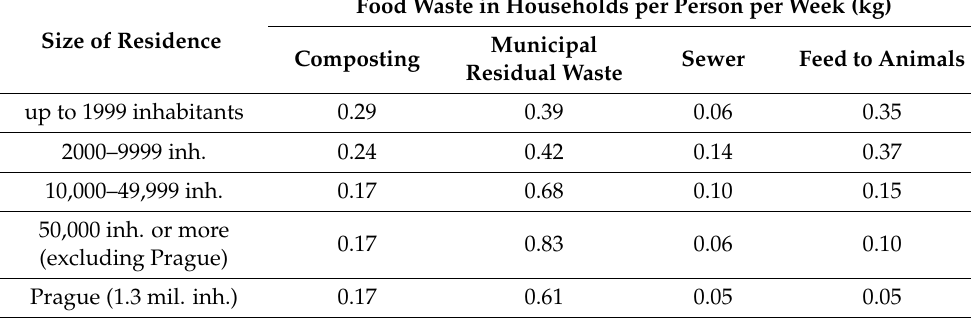
Table 7. Quantity of households’ food waste by disposal route and residence size. Food Waste in Households per Person per Week Size of Residence